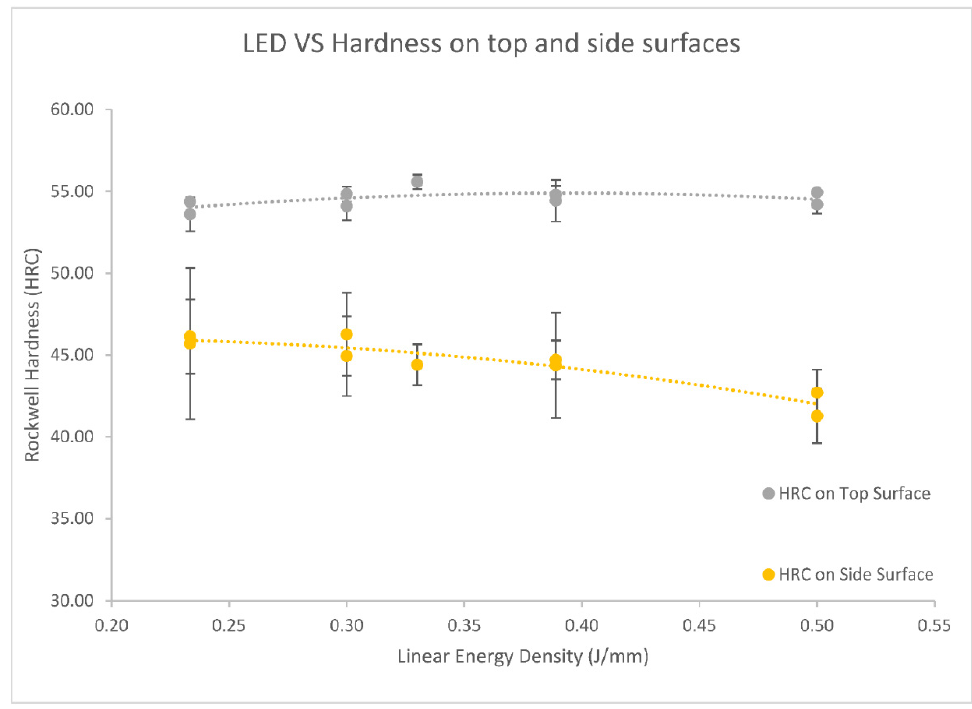
Figure 11. Effects of the interaction of parameters on the measured R a on the side surface.